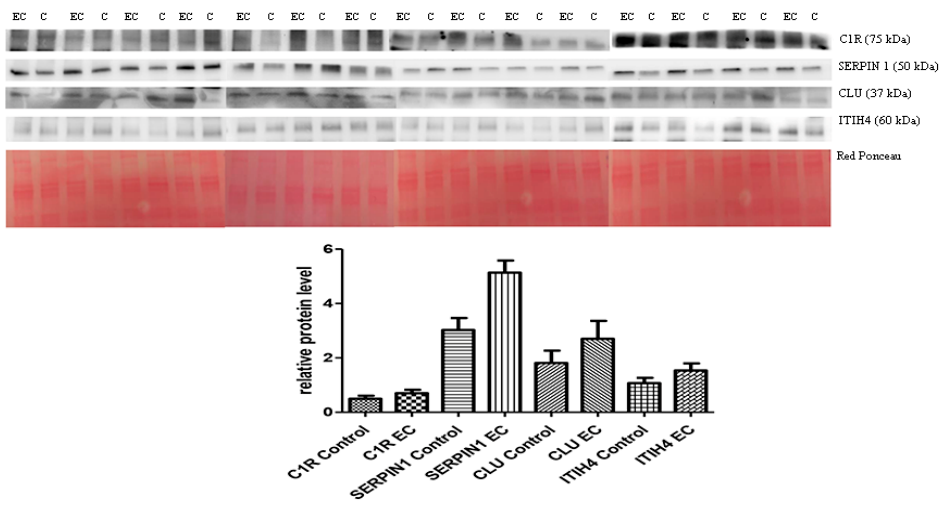
Figure 2. Western blotting analysis of four proteins ITIH4, CLU, SERPIN1, and C1R in controls (C) and endometrial cancer (EC) patients. The intensity of immunostained bands was normalized against the total protein intensities measured from the same blot stained with Red Ponceau (Den- sitometry Readings available as Supplementary File S2). The graph shows the relative abundance of proteins in control and endometrial cancer serum. Only SERPIN1 levels were significantly as- sociated with EC ( p = 0.010). Results are shown as a histogram ( p < 0.05) and each bar represents mean ± standard deviation (C1R control mean = 0.49 ± 0.42, C1R ADK mean = 0.7 ± 0.48; SERPIN1 control mean = 3.02 ± 1.7, SERPIN1 ADK mean = 5.1 ± 0.71; CLU control mean = 1.81 ± 1.77, CLU ADK mean = 2.7 ± 2.55; ITIH4 control mean = 1.07 ± 0.74, ITIH4 ADK mean = 1.53 ± 1.02).